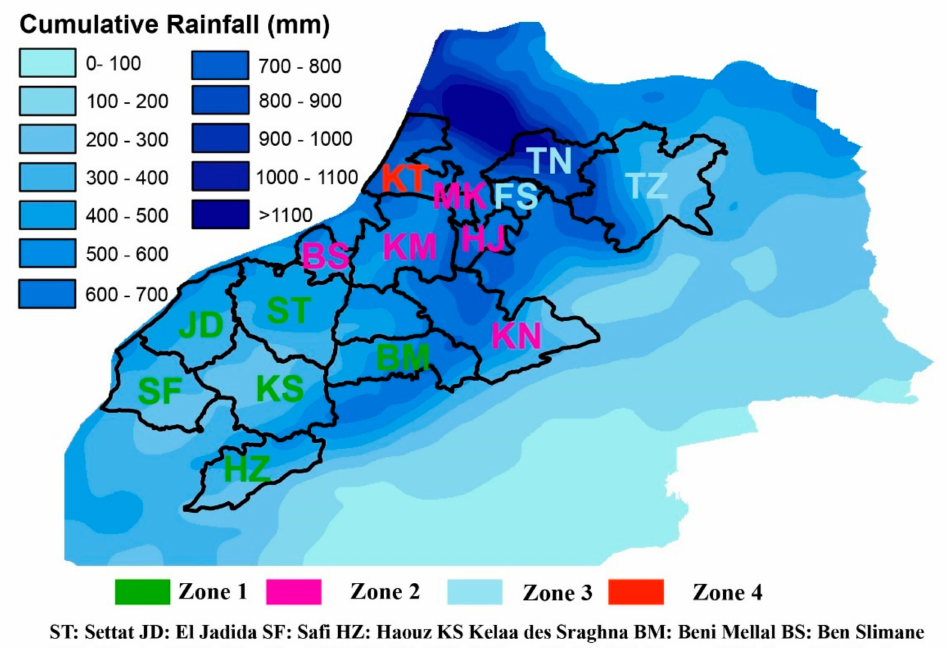
Figure 2. Average rainfall derived from ERA5 (2000–2017) accumulated during the cereal crop season (from November to